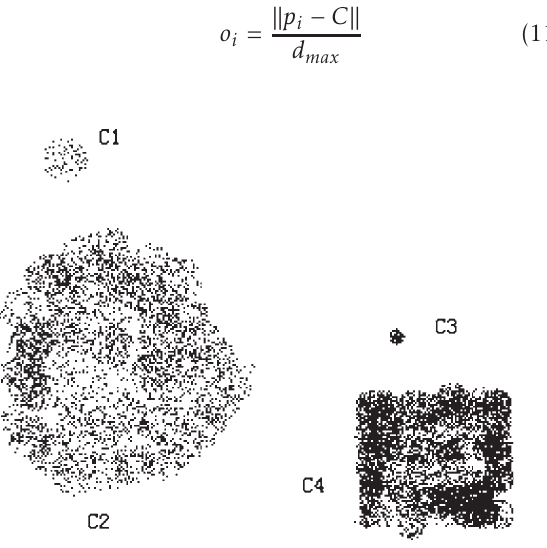
Figure 8. Anomalous clusters C1,C3 ; adapted from [22] 3. Assumption 3: In this scenario, it is assumed that in a dataset normal data objects are significantly high in volume than the anomalies. As a result, after clustering the dataset, smaller and sparser clusters are considered as anomalous and thicker clusters are normal. The instances belonging to clusters whose size and/or density is below a threshold are considered anomalous.